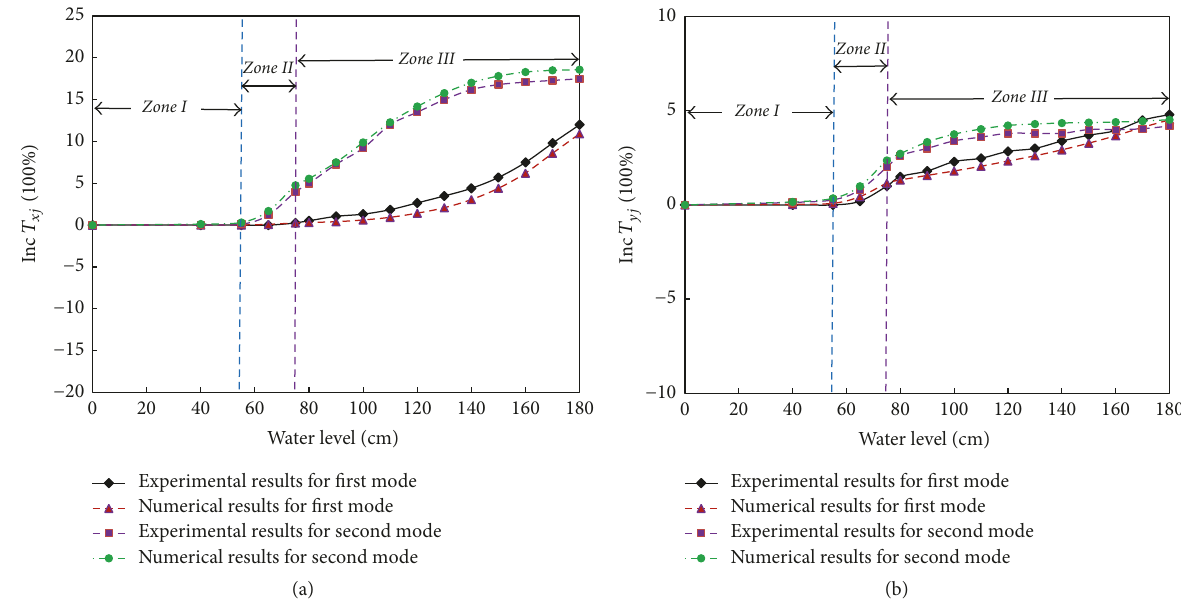
Figure 12: Measured and computed period percentage increases for the pier specimen without tip mass as a function of water level: (a) the first two lateral modes along 𝑥 -axis; (b) the first two lateral modes along 𝑦 -axis.